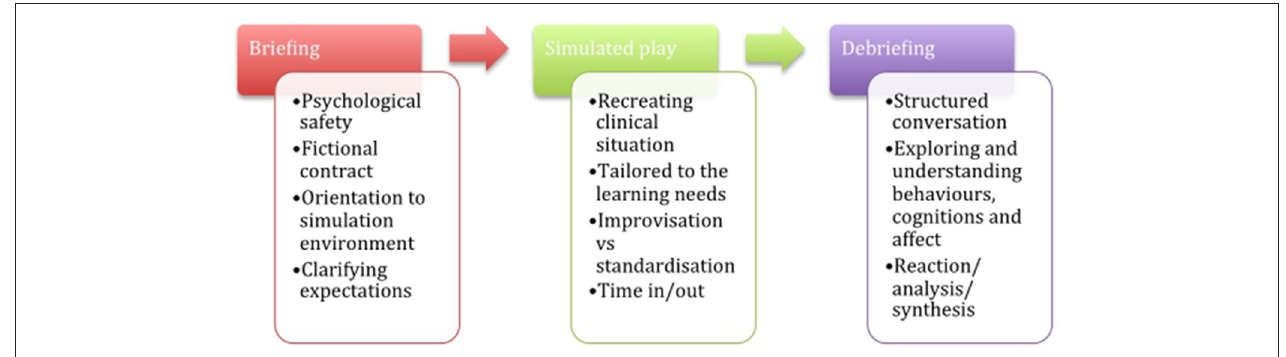
FIGURE 1 | The basic three stages process of